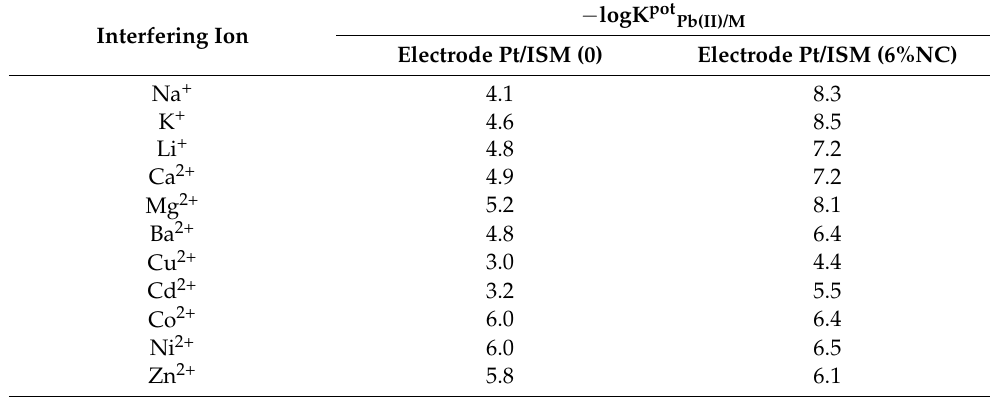
Table 3. Selectivity coefficients values determined for the Pt/ISM (0) and Pt/ISM (6%NC) electrodes. − logK pot Pb(II)/M Interfering Ion Electrode Pt/ISM (0) Electrode Pt/ISM (6%NC) Na